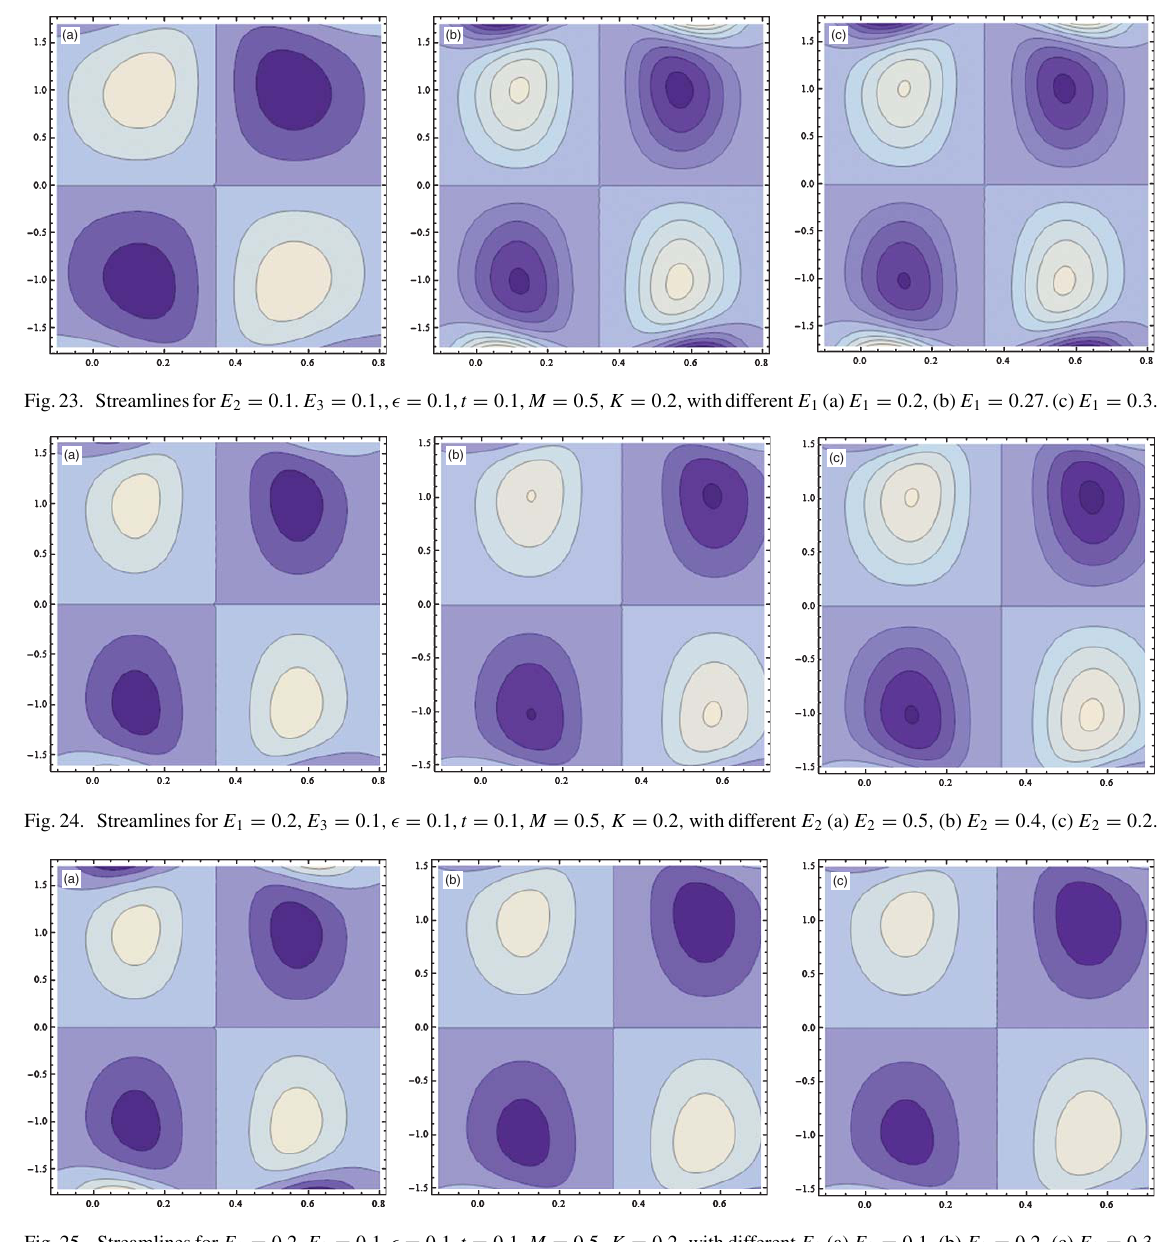
Fig. 25. Streamlines for E 1 = 0 . 2, E 2 = 0 . 1, (cid:15) = 0 . 1, t = 0 . 1, M = 0 . 5 , K = 0 . 2 , with different E 3 (a) E 3 = 0 . 1 , (b) E 3 = 0 . 2 , (c) E 3 = 0 . 3